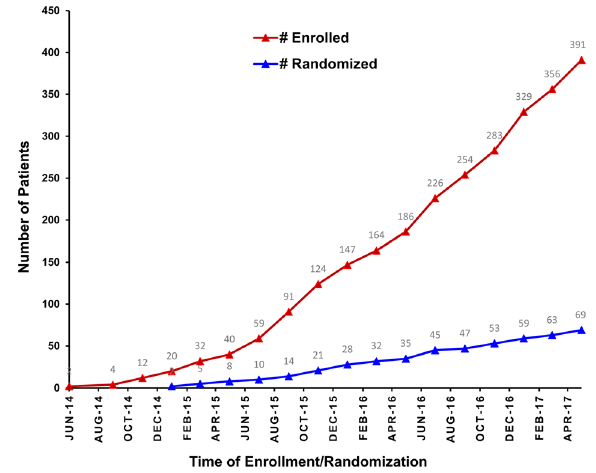
Fig. 1 Patient enrollment and randomization by time.